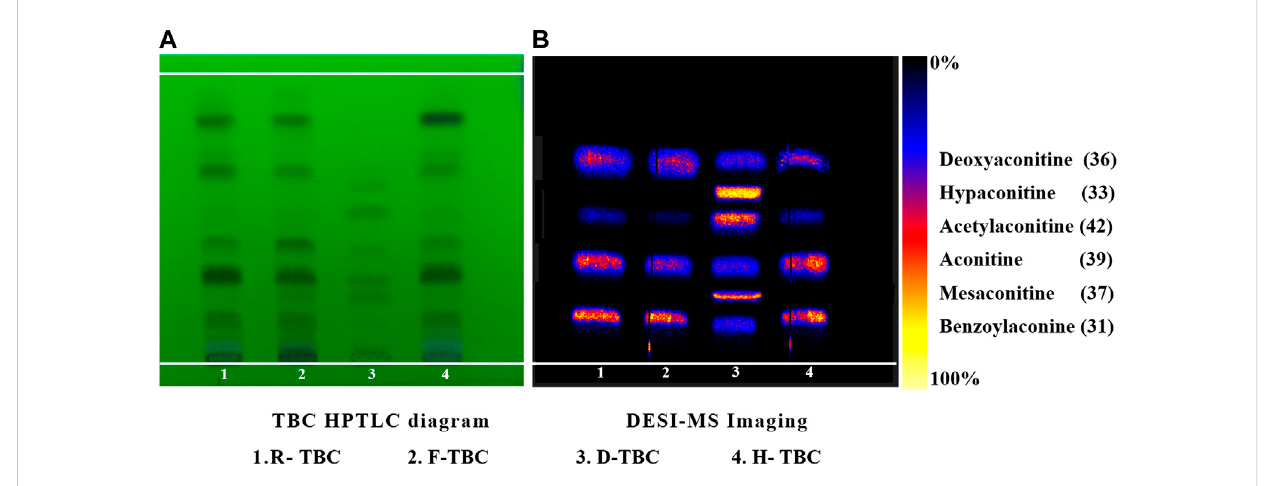
FIGURE 4 HPTLC and DESI diagrams of target control alkaloids in R-TBC, H-TBC, and